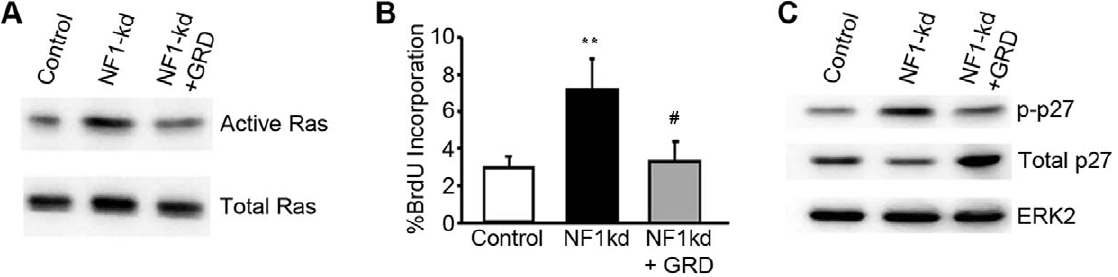
Figure 4. Enhanced proliferation following the loss of NF1 is a consequence of Ras activation. HUVECs were double infected with vectors coding for inducible NF1 knockdown shRNA and inducible expression of the GAP-related domain (GRD) of NF1 or empty vector. Cells were incubated for 24 h in the presence of 0.5 m g/ml doxycycline to induce expression of NF1 shRNA as well as the co-infected cDNA (GRD or empty). Control cells are cultured in the absence of doxycycline to suppress expression of and cDNA. After 24 h in the presence or absence of doxycycline, cells were switched to serum-free medium. (A) Cells were analyzed for the presence of active Ras using GST-pull down. Total Ras was used to insure equivalent protein in the input lysates. (B) BrdU incorporation was measured 24 h after changing to serum and growth factor free conditions. Data represents the averages from triplicate determinations and error bars represent standard error of the mean. (**p , 0.01 compared to Control; # p , 0.01 compared to NF1-kd, (C) Lysates prepared under the conditions described above were probed for changes in phosphorylation of p27 and total p27 levels by western blotting. ERK was monitored as a loading control. All experiments were replicated in an independently generated set of doubly infected cells.